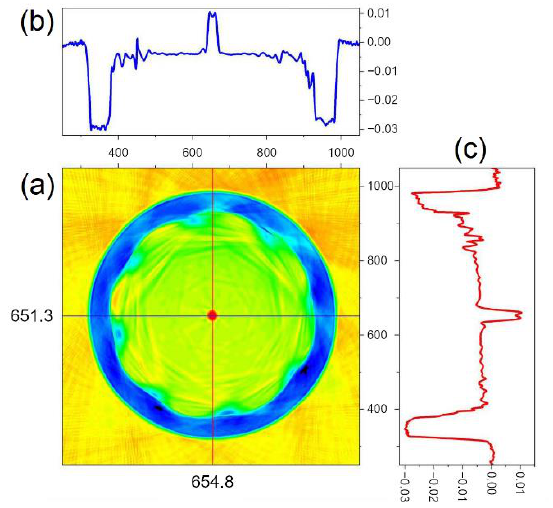
Figure 3. ( a ) EYDF cross-section refractive index difference measurements: ( b ) along the horizontal axis, ( c ) along the vertical axis.